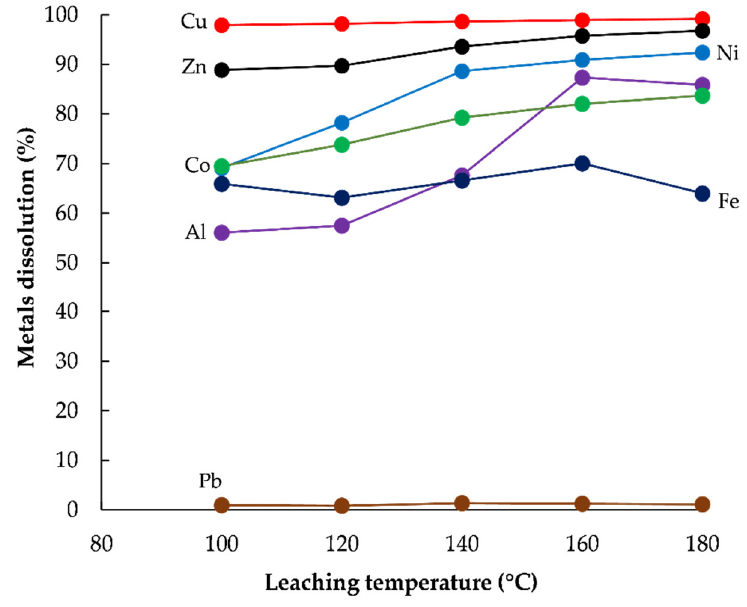
Figure 7. Extraction percentage of base metals as a function of temperature. (Conditions: 1 M H 2 SO 4 , 100–180 °C, 10 g/t pulp density, 750 rpm stirring speed, 2 MPa pressure for 30 min leaching).